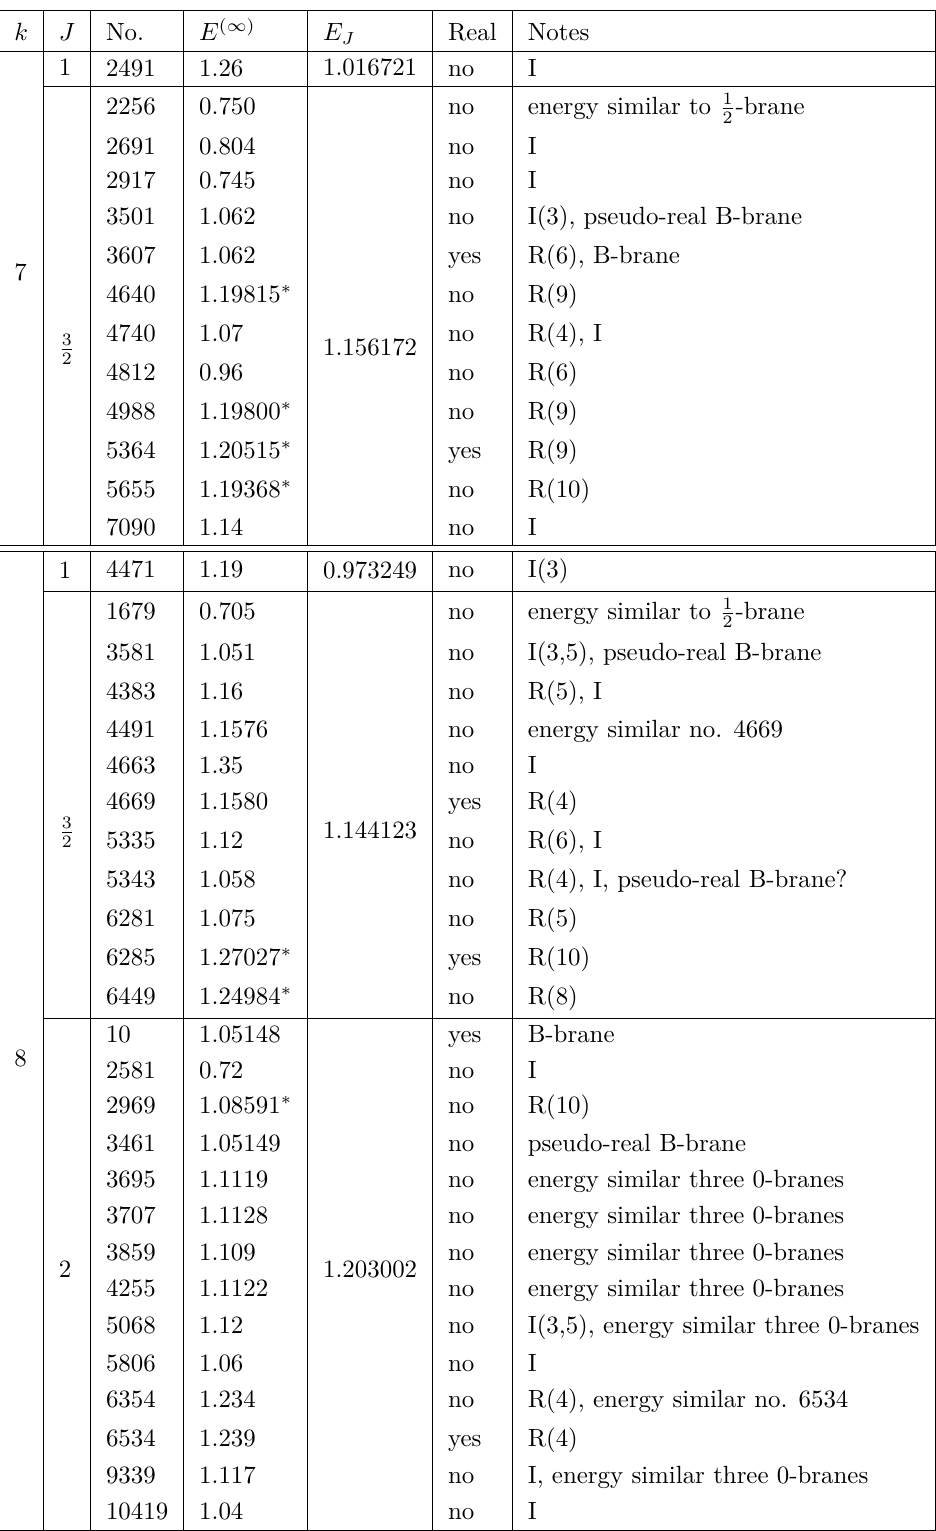
Table 28 . List of exotic solutions in the SU(2) k WZW model with k ≤ 8 , part